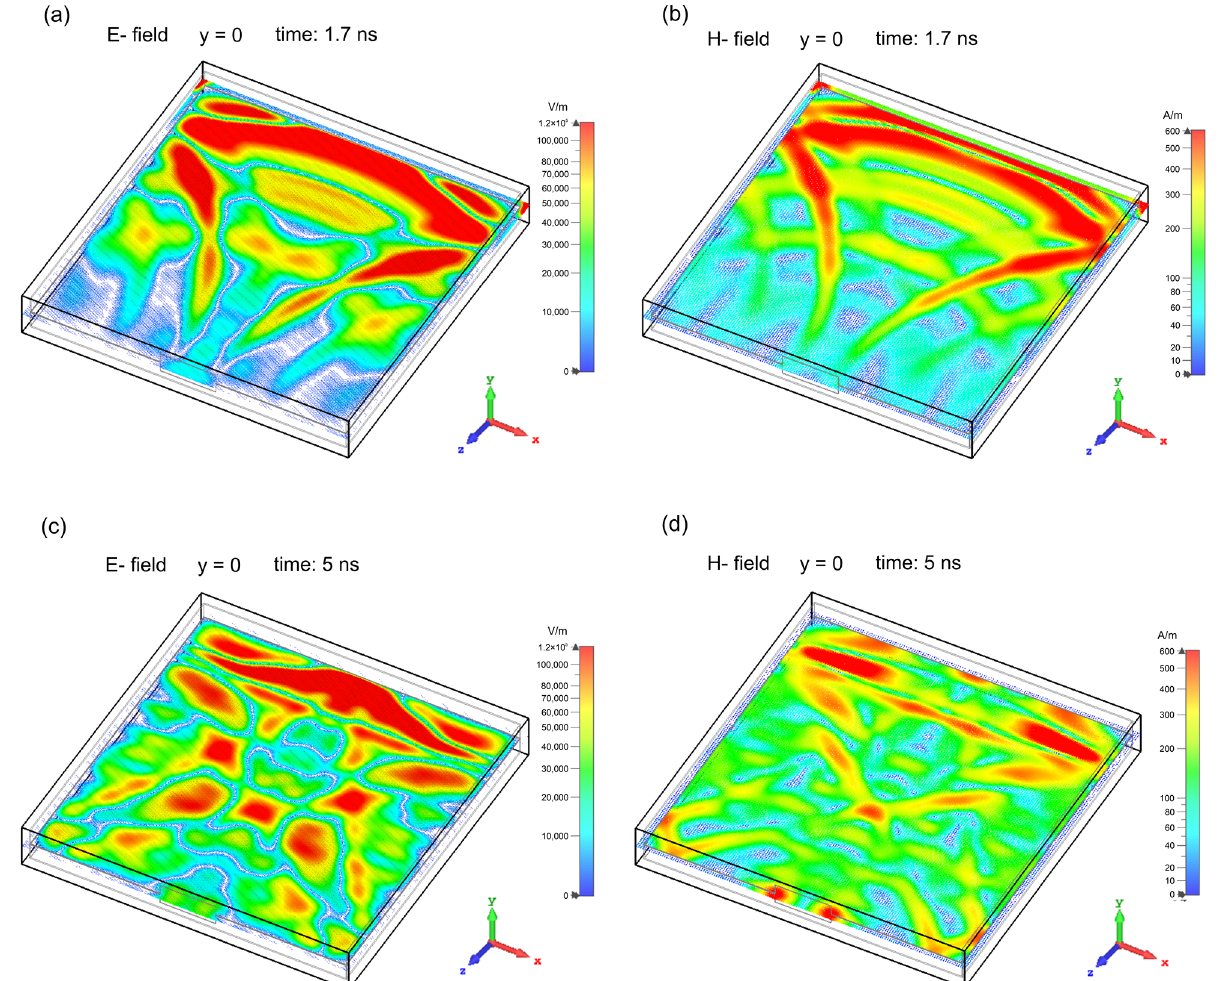
Figure 5. 2D images illustrating development of the electric and magnetic fields in the enclosure in the interference phase at various times. Left column —the electric field amplitude, right column —the magnetic field amplitude. ( a , b ) and ( c , d ) show the electric and magnetic fields at times t = 0.96 ns and t = 1.5 ns, respectively.